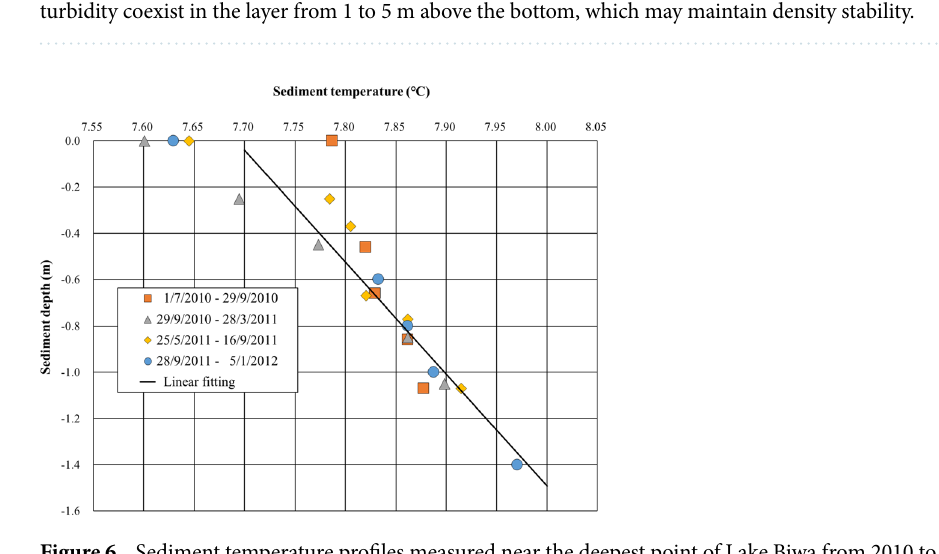
Figure 6. Sediment temperature profiles measured near the deepest point of Lake Biwa from 2010 to 2012 (location indicated in Fig. 3). Plotted are the average data during four periods: July 1 to September 29, 2010; September 29, 2010 to March 28, 2011; May 25 to September 16, 2011; September 28, 2011 to January 5, 2012 and the linear regression fitted line for all data. This line indicates an upward heat flux of 0.2 K m −1 from the sediment to the